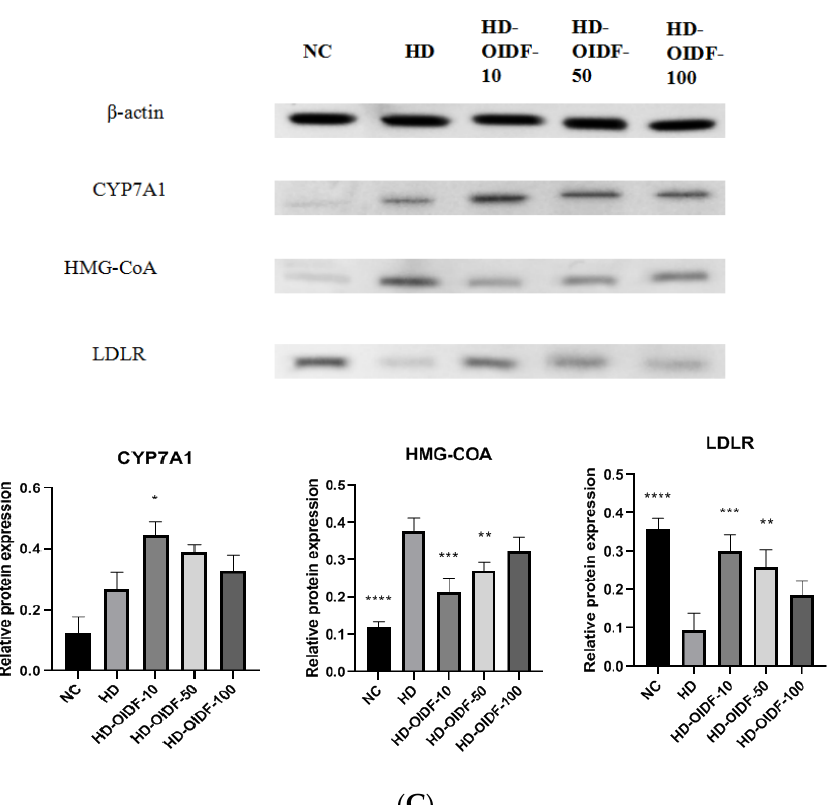
Figure 5. Effects of different particle sizes of OIDF on diet-induced hepatic steatosis in mice. Histological changes in liver sections were measured by H&E staining at 400 × magnification: ( A ) Relative mRNA expression levels of CYP7A1, HMG-CoAr, LDL-R were determined by qRT-PCR; ( B ) The protein expressions of CYP7A1, HMG-CoAr and LDL-R in liver were determined by Western blotting; ( C ) Values are expressed as mean ± SD ( n = 10). * represents p < 0.05, ** represents p < 0.01, and *** represents p < 0.001, and **** represents p < 0.0001, compared to the HD group. NC, normal